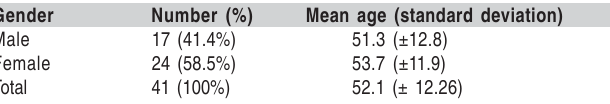
Table 1. Demographic characteristics of the sample.